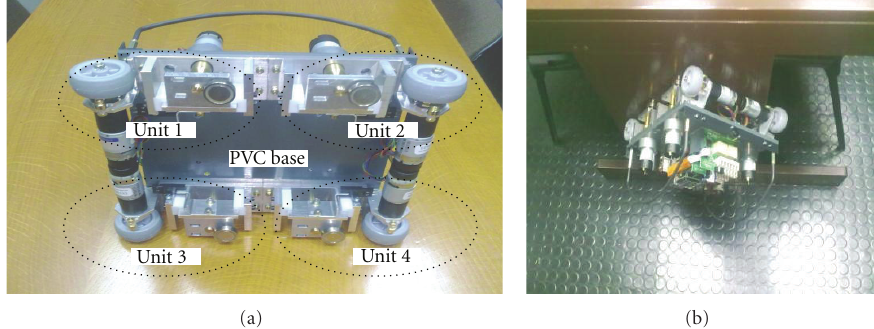
Figure 7: Mechanical structure of the robot, with the four modular standard units assembled on it (a), and view of the assembled robot (without the electronics) standing on a vertical ferromagnetic surface (b).